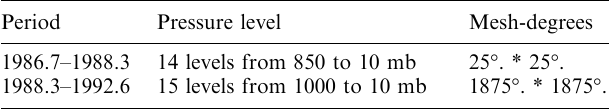
Table 1. Characteristics of GANL data from Japanese Meteor- ological Agency Period Pressure